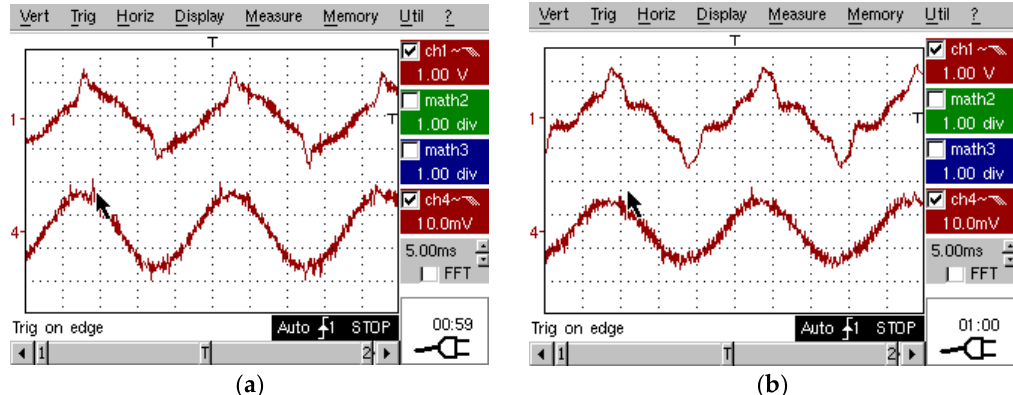
Figure 15. Oscillograms of currents on phases A ( a ) and B ( b ), downstream (top) and upstream (bottom) of the PCC. The distortion of the load currents is different in the three phases, respectively THD is of 10–40% (Figures 16–19). After the harmonic compensation, THD is reduced to 3.5–5% (Figures 16–18).